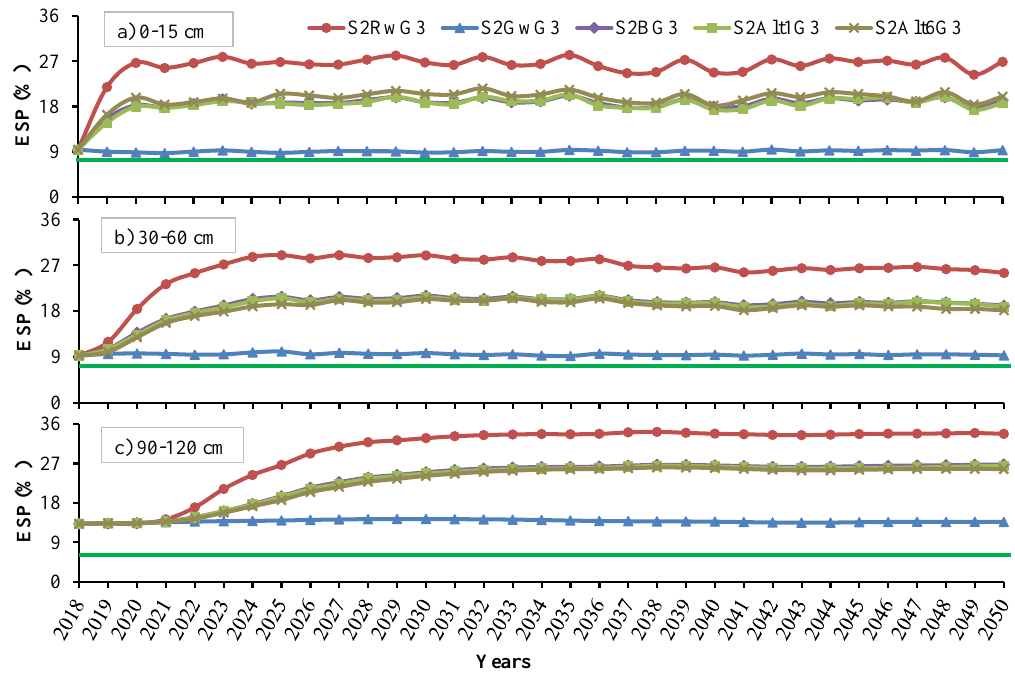
Figure 11. Impact of different water qualities (recycled water, RW; good water, GW; blending of RW and GW in a 1:1 ratio, B; RW and GW used in monthly cycles, Alt1; and RW and GW used in half-yearly cycles, Alt6) and annual gypsum applications of 8.6 t/ha (G3) on annual ESP for hard red-brown soil (S2) under almond cultivation.